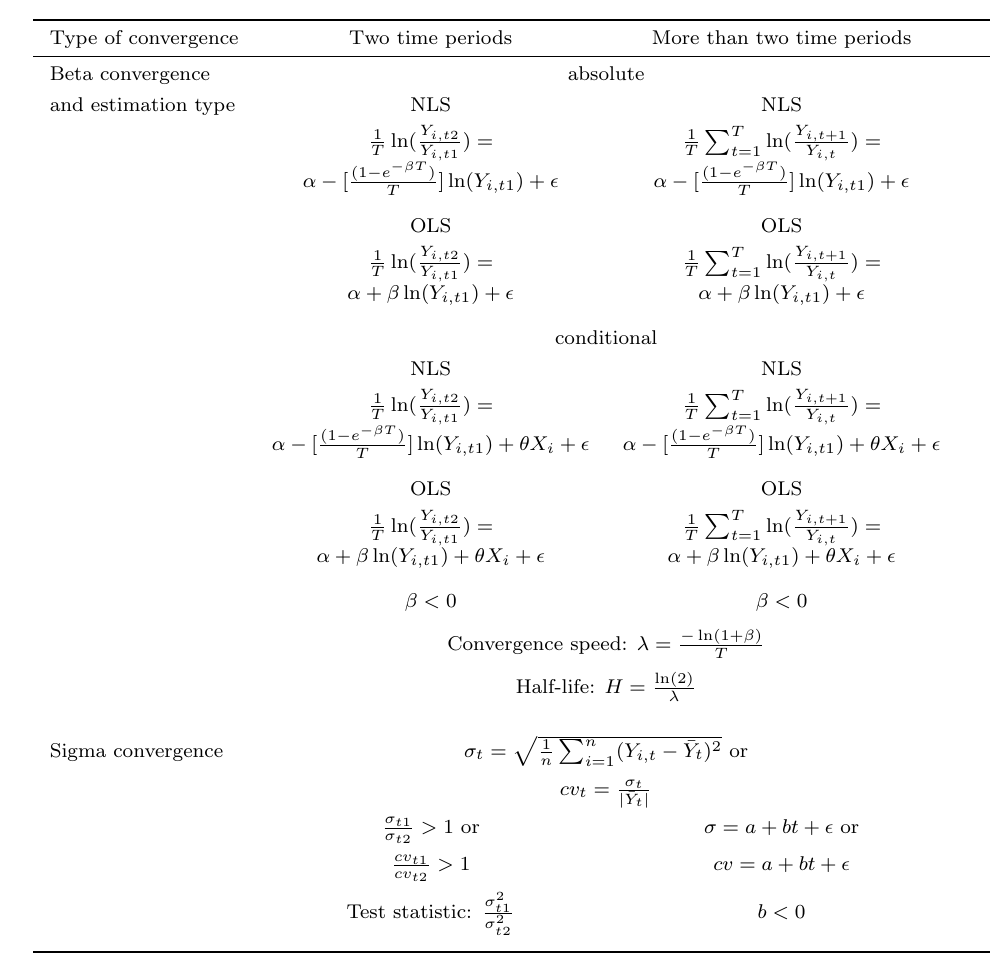
Table 3: Beta and sigma